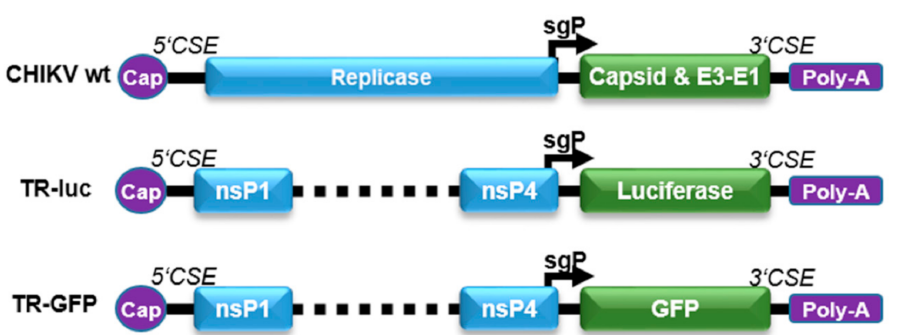
Figure 1. Reporter TR-RNA constructs. The reporter RNA constructs were designed by deleting the nsP1–4 proteins. The first 231 nt of nsP1, the last 1818 nt of nsP4, and the conserved sequence elements (5’CSE and 3’CSE) were retained in the RNA to allow monitoring of specific viral replication. The luciferase or GFP reporter gene was inserted after the sgP, replacing the structural proteins.